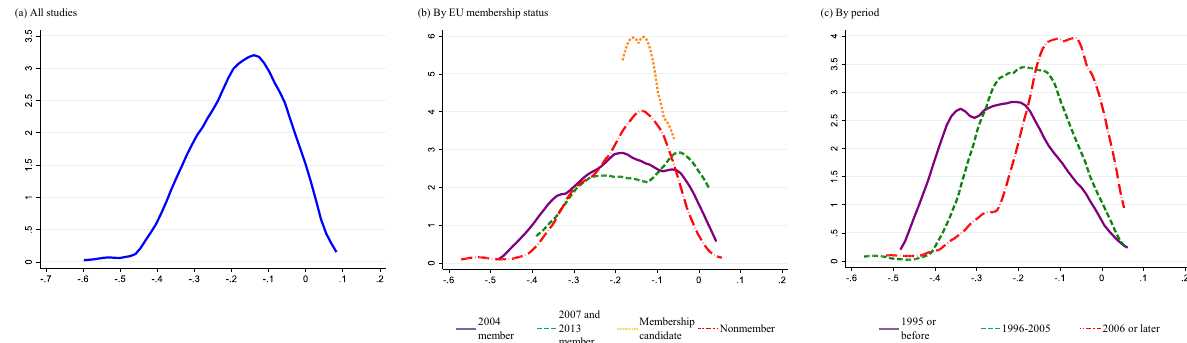
Fig. 1 Kernel density estimation of collected estimates. This figure illustrates Kernel density estimation of 670 estimates of the gender dummy variable included in the meta-analysis. The Epanechnikov kernel function was used for estimation. The vertical axis is the kernel density. The horizontal axis is the partial correlation coefficient of collected estimates. Kernel density estimation was conducted by EU membership status and estimation period, and the results are shown in Panels b and c , respectively, in addition to that for all studies in Panel a . See Table 1 for the descriptive statistics of